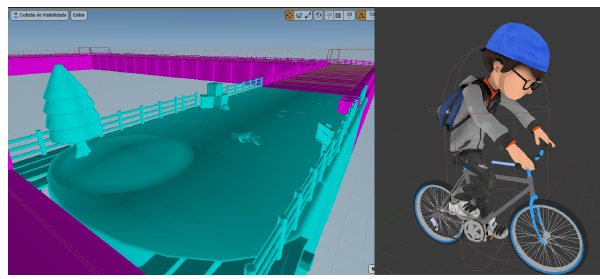
Figure 6. Scenario and character developed for the